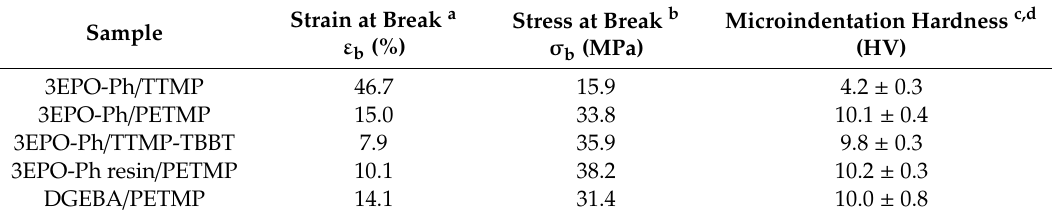
Figure 8. Stress-strain plot of tensile tests of the different materials prepared. Table 4. Mechanical data from stress-strain and hardness testing of the thermosets prepared. Coefficients of variation less than 5% for stress, strain and tensile modulus.